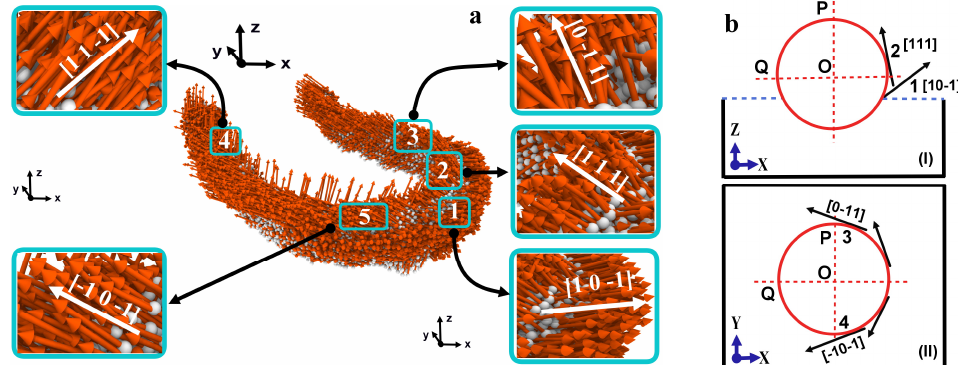
Figure 6. Displacement vector distribution diagram of abrasive debris atoms in front of the grinding ball: ( b ) is a schematic diagram corresponding to ( a ) .